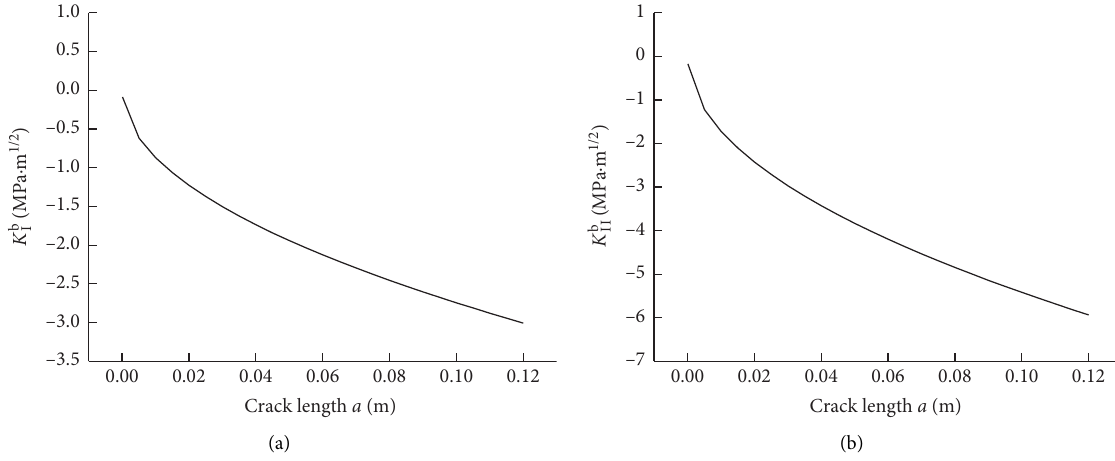
Figure 11: Relationship between closed crack length and stress intensity factor ( θ � 70 ° ). (a) Mode I. (b) Mode